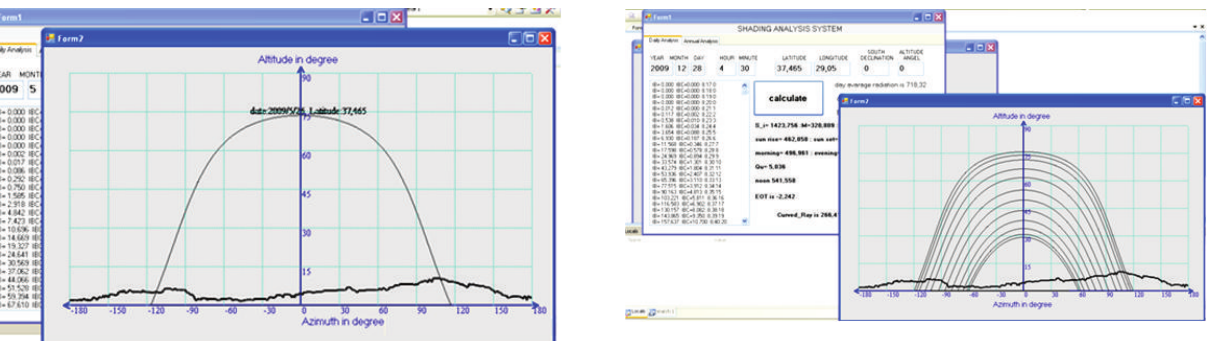
Figure 14: The screenshot of the developed software for the whole